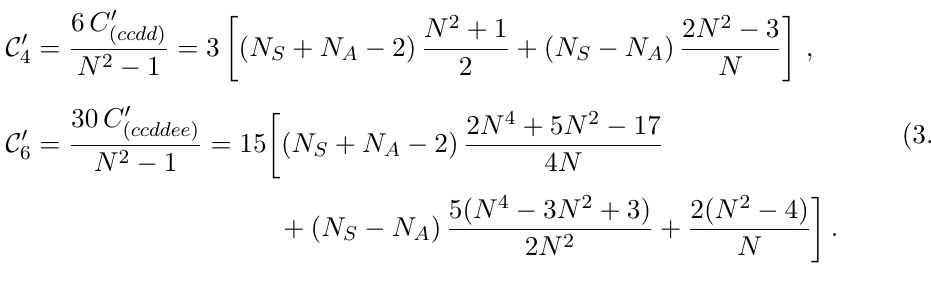
Table 3 . The coe(cid:14)cients and for the (cid:12)ve families of conformal theories de(cid:12)ned in table 1. C 0 4 C 0 6 Using the expressions of the tensors C 0 for the (cid:12)ve families of superconformal SU(N) theories that can be obtained from the formul(cid:26) in appendix A with the help of Form Tracer [62], one